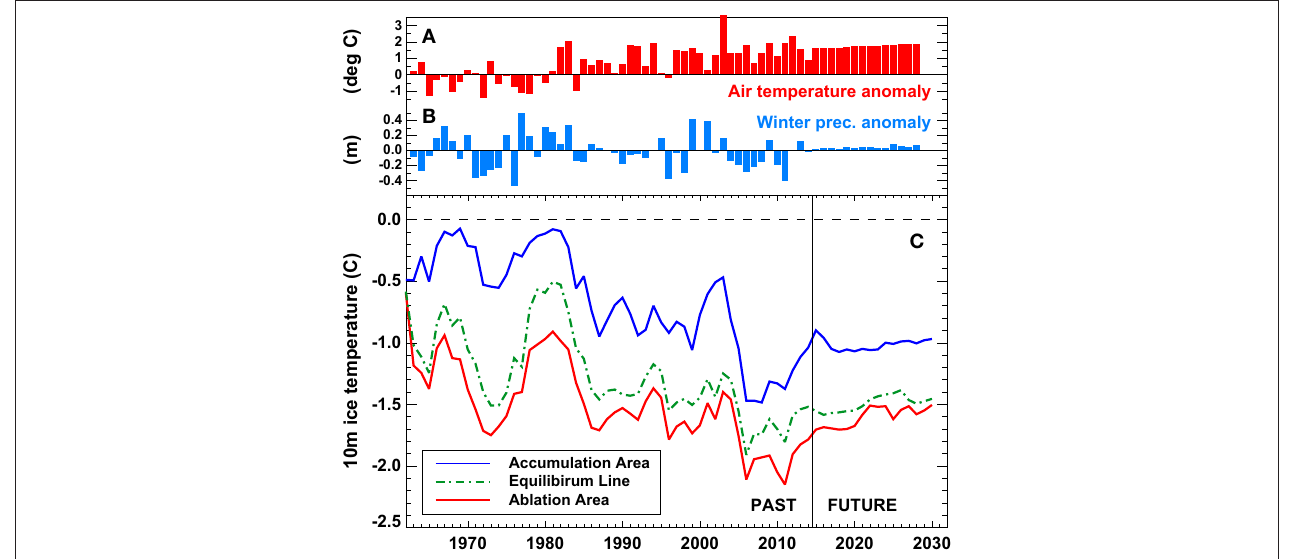
FIGURE 10 | Anomalies of (A) summer temperature and (B) winter precipitation relative to the period 1961–1990. (C) Calculated change in englacial temperature at 10m depth for sites in the accumulation area, at the ELA and in the ablation area. Time series represent averages of all very small glaciers > 0.1km 2 .